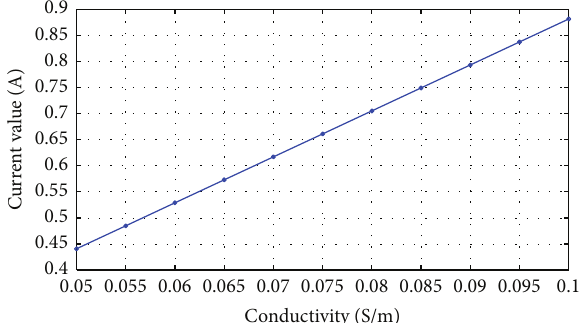
Figure 9: Curve of the maximum current value with the conductiv-